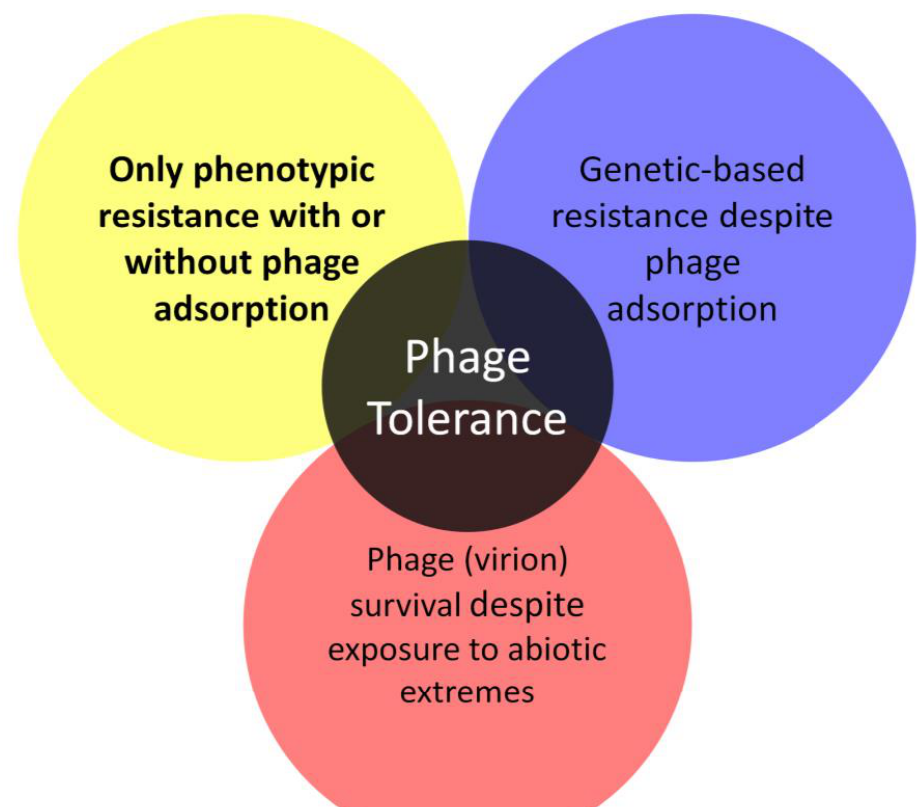
Figure 2. Multiple historical meanings of phage tolerance. The focus of this review is on the upper-left meaning, emphasized in bold, though with the additional meanings discussed in Box 1.